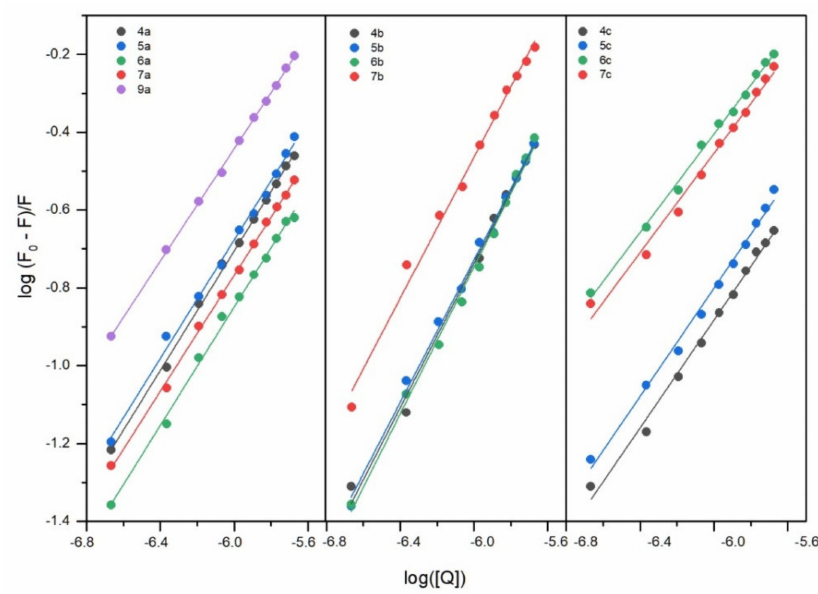
Figure 10. Fluorescence spectra of BSA solution in presence of studied compounds (T-297 K, λ ex = 280 nm). The concentration of a, b and c was as follows: 0, 0.2, 0.4, 0.6, 0.8, 1.0, 1.2, 1.4, 1.6, 1.8, 2.0 µ M.